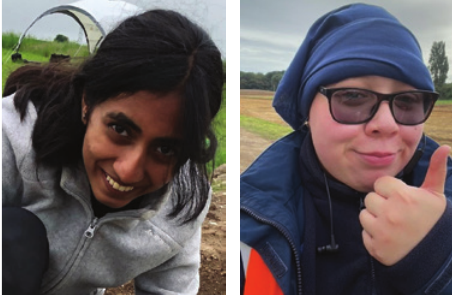
Figure 7 BA Archaeology with Placement Year students Sakshi Surana (left) and Victoria Igary (right) (Source: photograph by